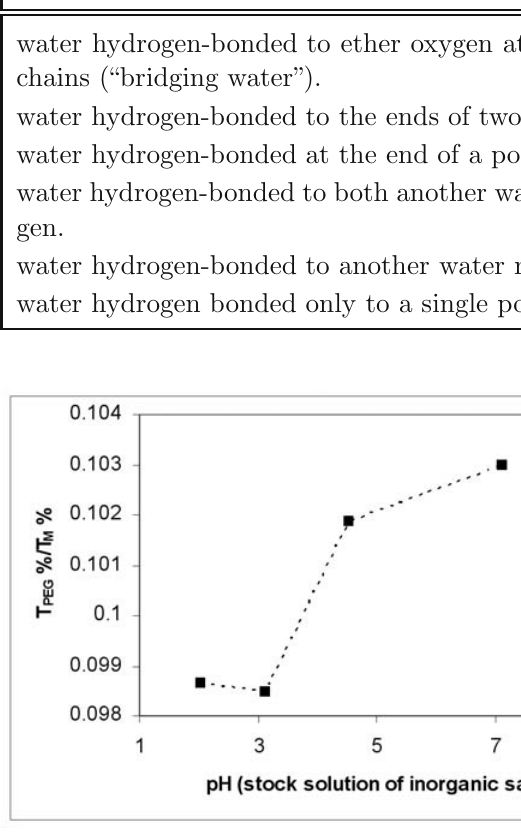
Fig. 2 Water band transmittance ratio: 40 % PEG before / after extraction with (NH 4 ) 2 SO 4 solutions at various